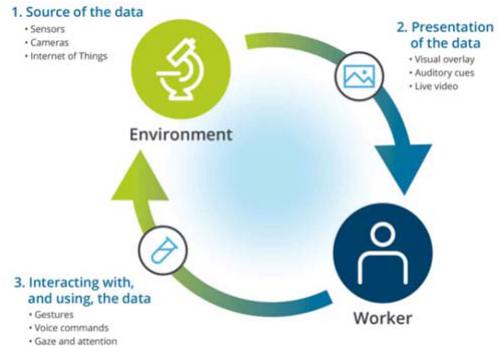
Figure 7. Augmented reality organization [40] Figure 7. is a visual representation of an augmented reality work organization between workers, the data (sensors, cameras, Internet of Things IoT), the presentation of the data (overlays, audio cues and live representation) and the interaction with the data (gestures, voice commands, gaze and attention). This all results in an environment which takes use of Augmented Reality